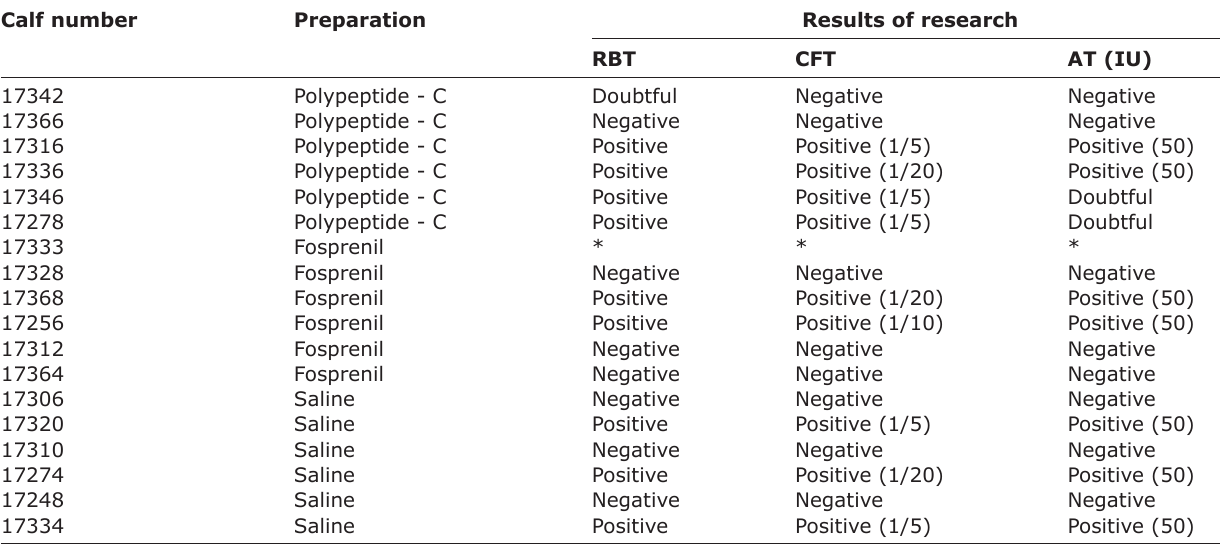
Table-2: The results of serological studies 30 days after vaccination (n=18). Calf